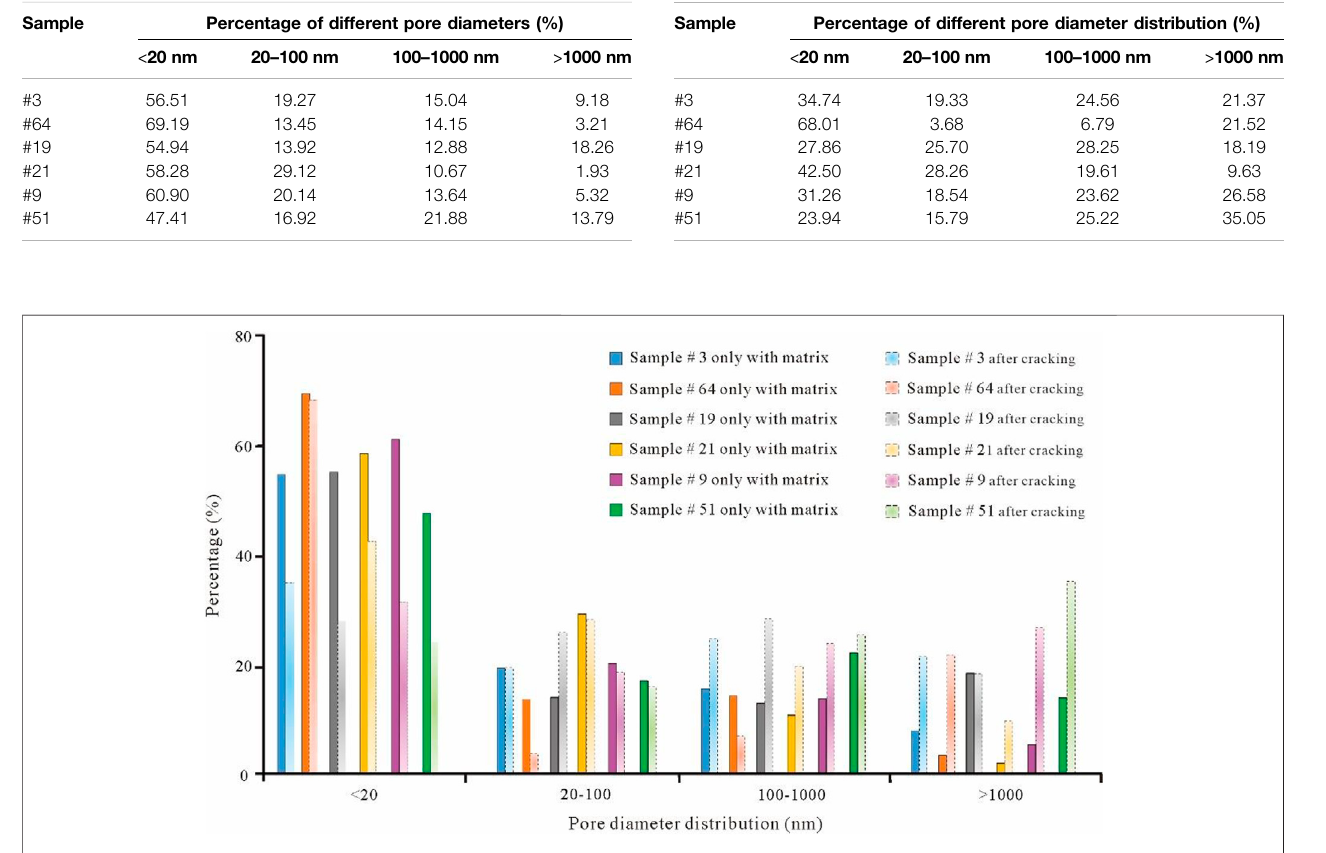
FIGURE 7 | Percentage histogram of pore diameters of cores before and after cracking.